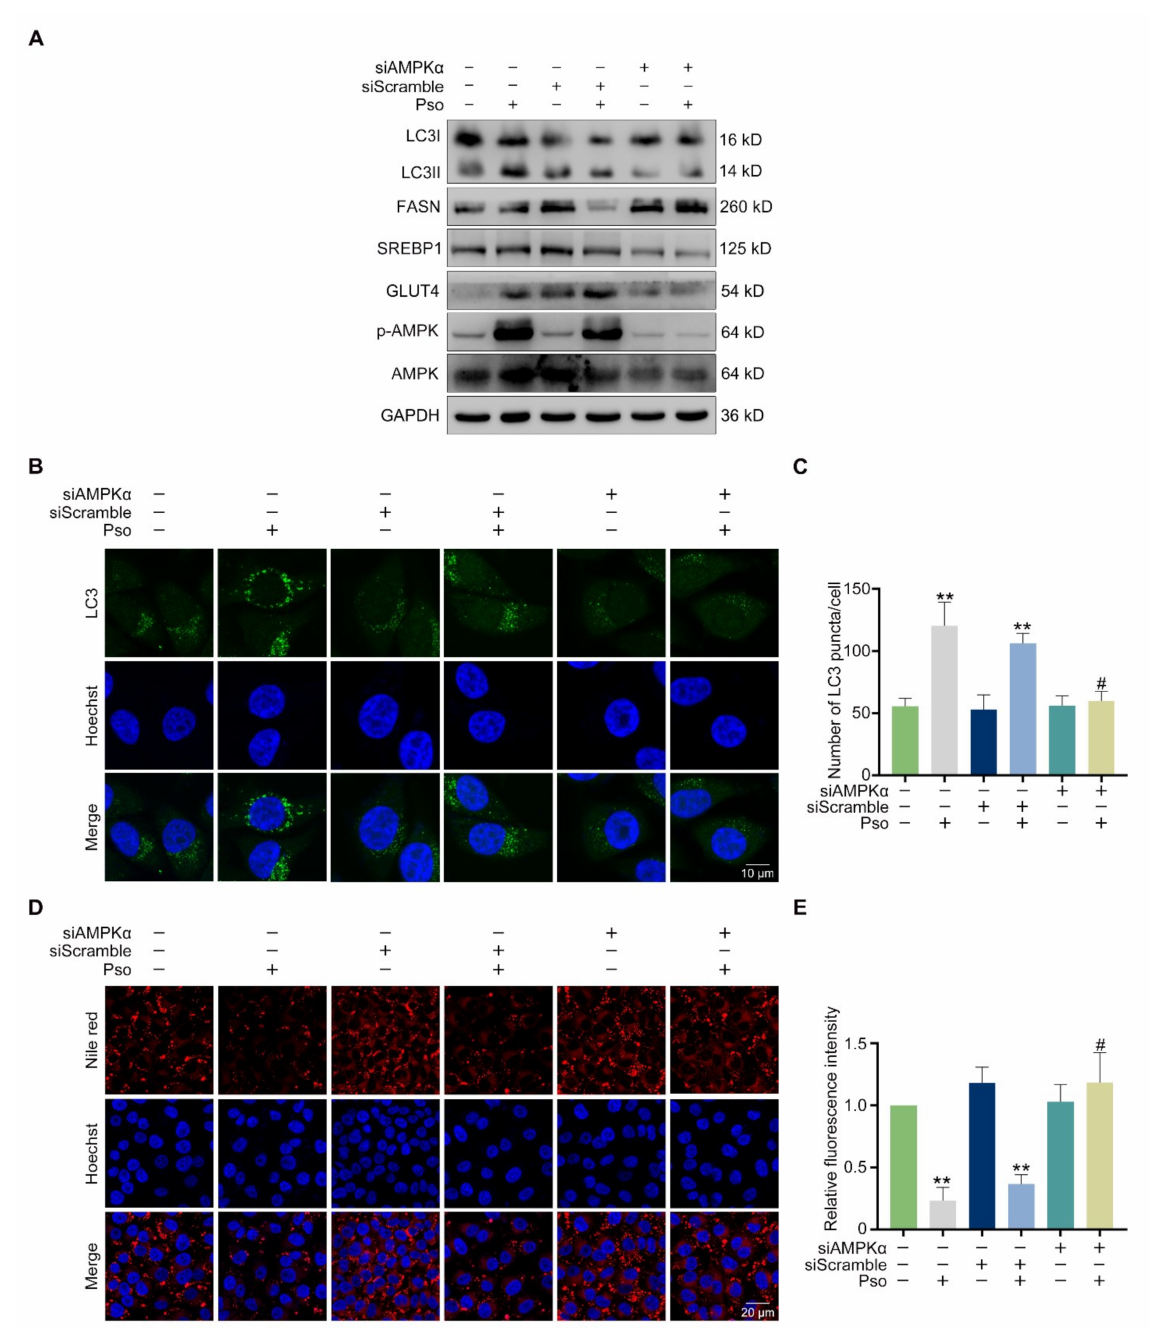
Figure 8. Psoralen attenuates lipid accumulation and lipogenesis via activating AMPK. L02 cells were transfected with siAMPK α or scramble, induced with sodium oleate (100 µ M) for 24 h, and treated with psoralen (3.3 µ M) for 24 h. ( A ) The expression of GLUT4, AMPK, p-AMPK, LC3I, LC3II, FASN, and SREBP1 was measured by Western blotting. ( B ) L02 cells were stained with anti-LC3 antibodies and Hoechst 33258 as visualized by confocal microscopy (scale bar = 10 µ m). ( C ) Quantification of LC3 puncta per cell. ( D ) Lipid accumulation was determined by Nile red staining and visualized by confocal microscopy (scale bar = 20 µ m). ( E ) Quantification of Nile red fluorescence intensity per cell. All values were expressed as the mean ± SD from three independent experiments. # p < 0.05 vs. psoralen treated group. ** p < 0.01 vs. sodium oleate-induced